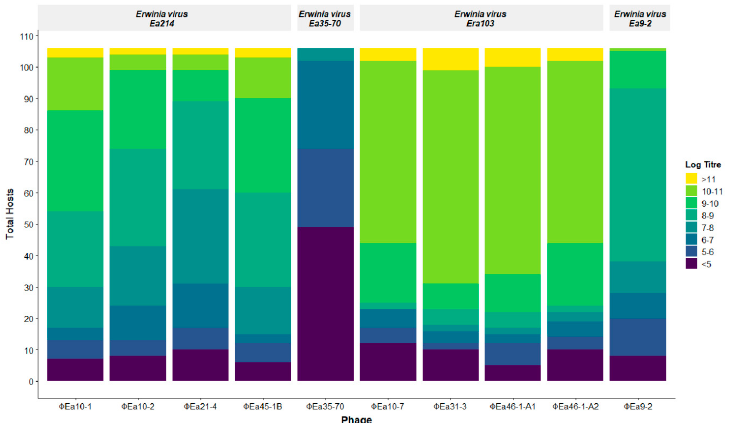
Figure 2. Distribution of phage productivity in all 106 Erwinia sp . hosts. Each colour represents the final genomic phage titre (genomes/mL) produced by a host, and the height of that colour is the number of hosts on which each phage achieves that titre. The log of the genomic titre is used for visual simplicity.